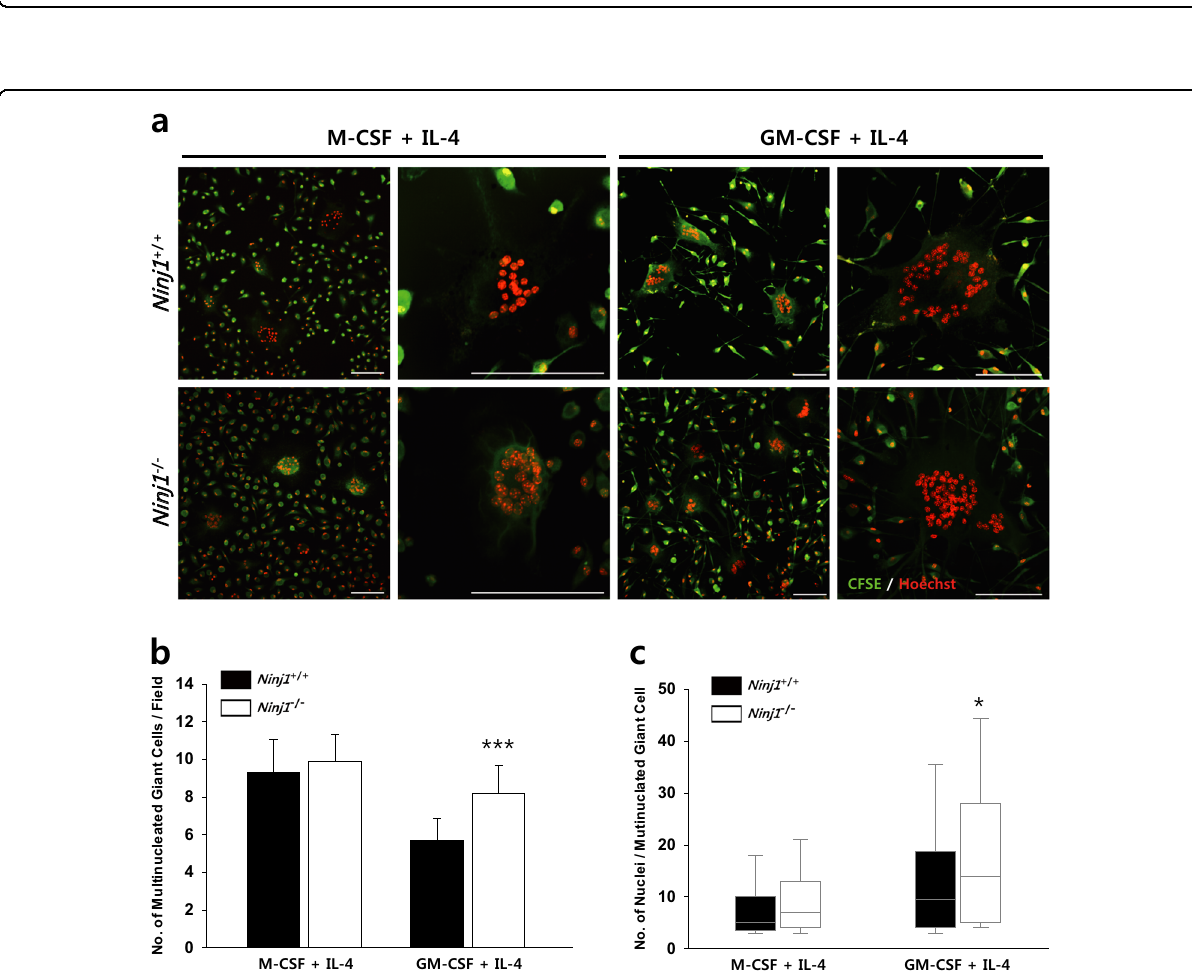
Fig. 4 Ninj1 − / − macrophages generate more multinucleated giant cells. a , c Multinucleated giant cells were induced by culturing BMMs with M- CSF + IL-4 (left) or GM-CSF + IL-4 (right) followed by staining with CFSE (green) and Hoechst (red). ( a ) Representative images of giant cells. Scale bars, 100 μ m. b Numbers of multinucleated cells are shown as the mean ± SD; *** P < 0.001. c Numbers of nuclei in multinucleated cells are presented in a median-quartile boxplot; * P <